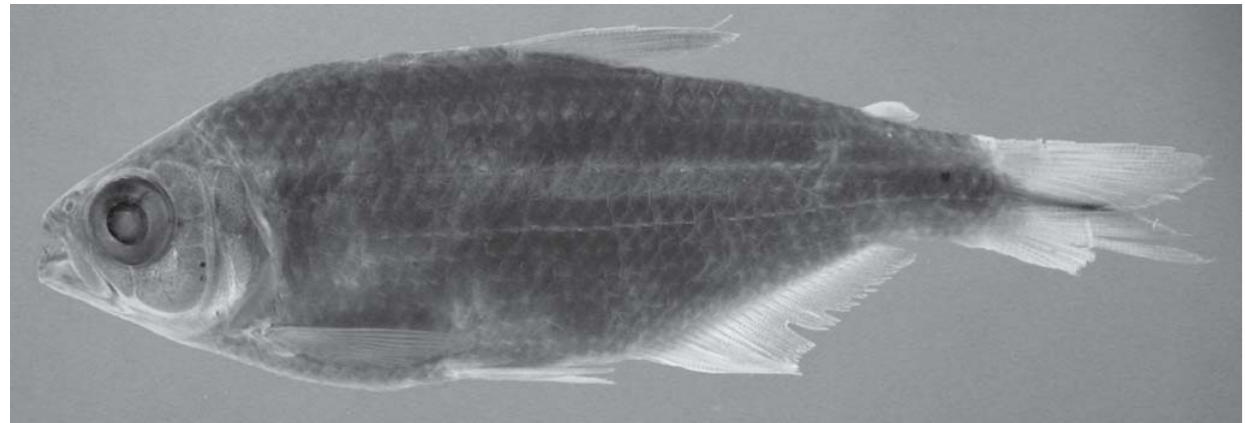
Fig. 3. Astyanax henseli , ZMB 7479, 78.0 mm SL, holotype, male, Porto Alegre, Rio Grande do Sul, Brazil.